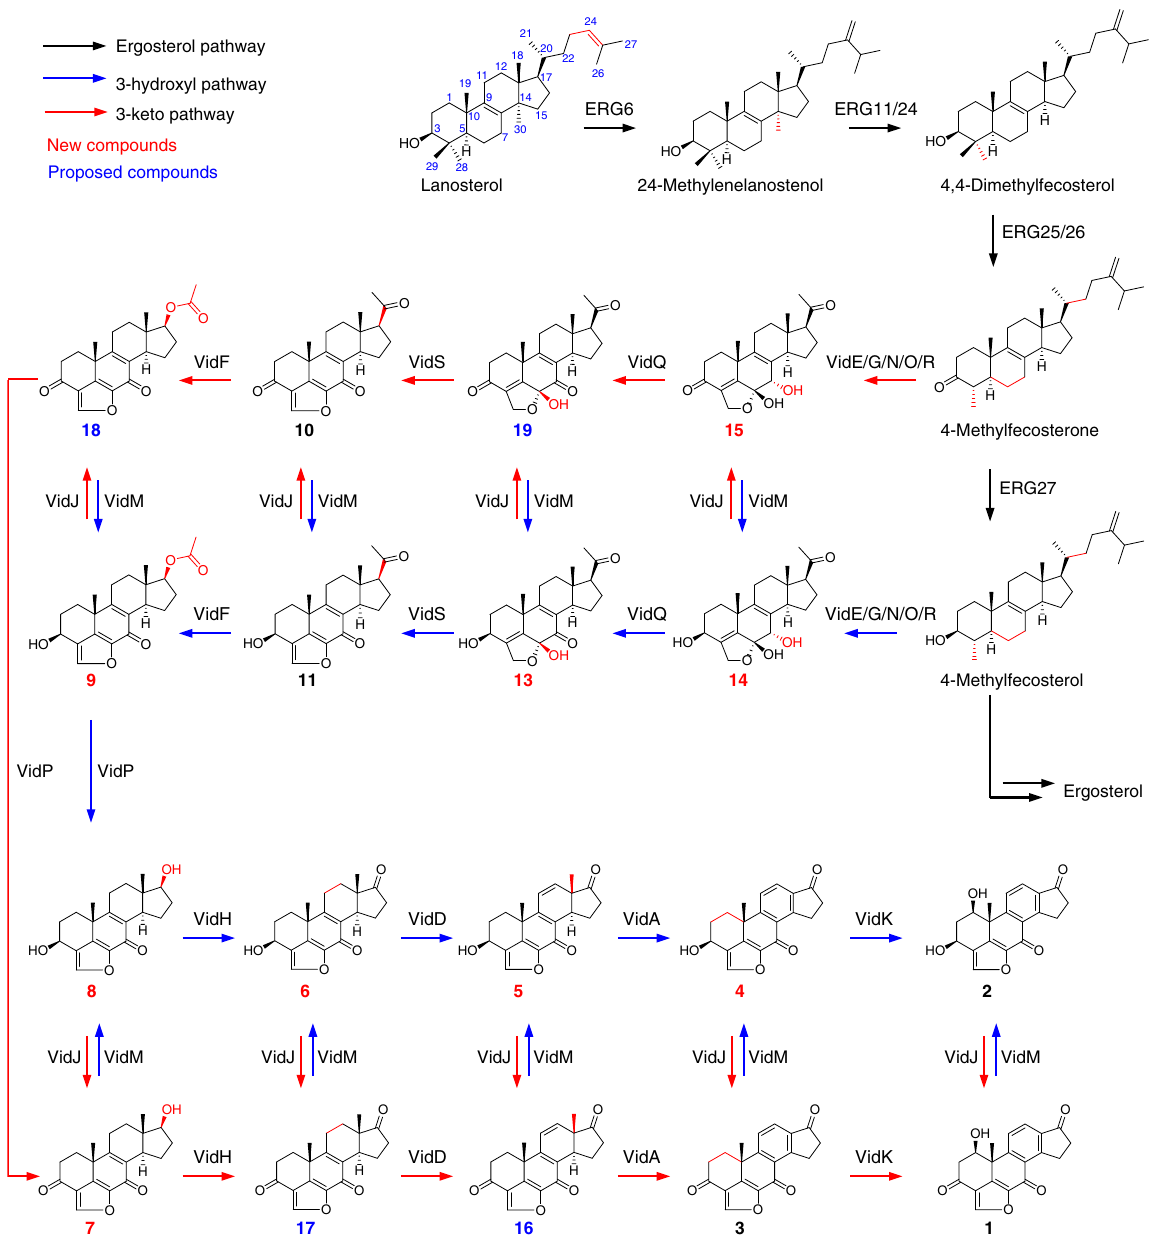
Fig. 3 Complete biosynthetic pathway of demethoxyviridin ( 1 ). Proposed biosynthetic pathway for 1 (marked by red arrows), and its 3-OH derivative 2 (marked by blue arrows). The ergosterol pathway is marked by black arrows. New compounds and proposed compounds are indicated by red and blue numbers, respectively. The enzyme-mediated modi fi cation sites in individual reaction are marked by